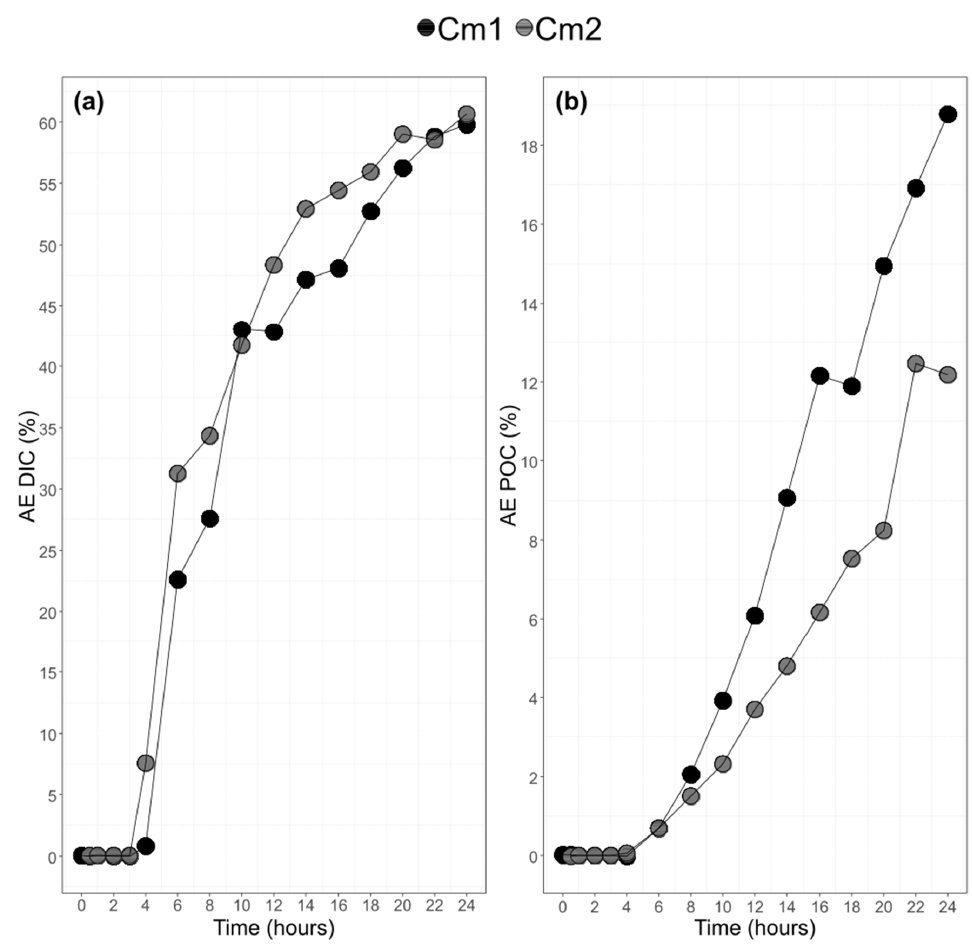
Figure 5. Atomic enrichment (AE) of the Dissolved Inorganic Carbon ( a ). Atomic enrichment (AE) of Particulate Organic Carbon ( b ) (Cm = Chaetoceros muelleri ).